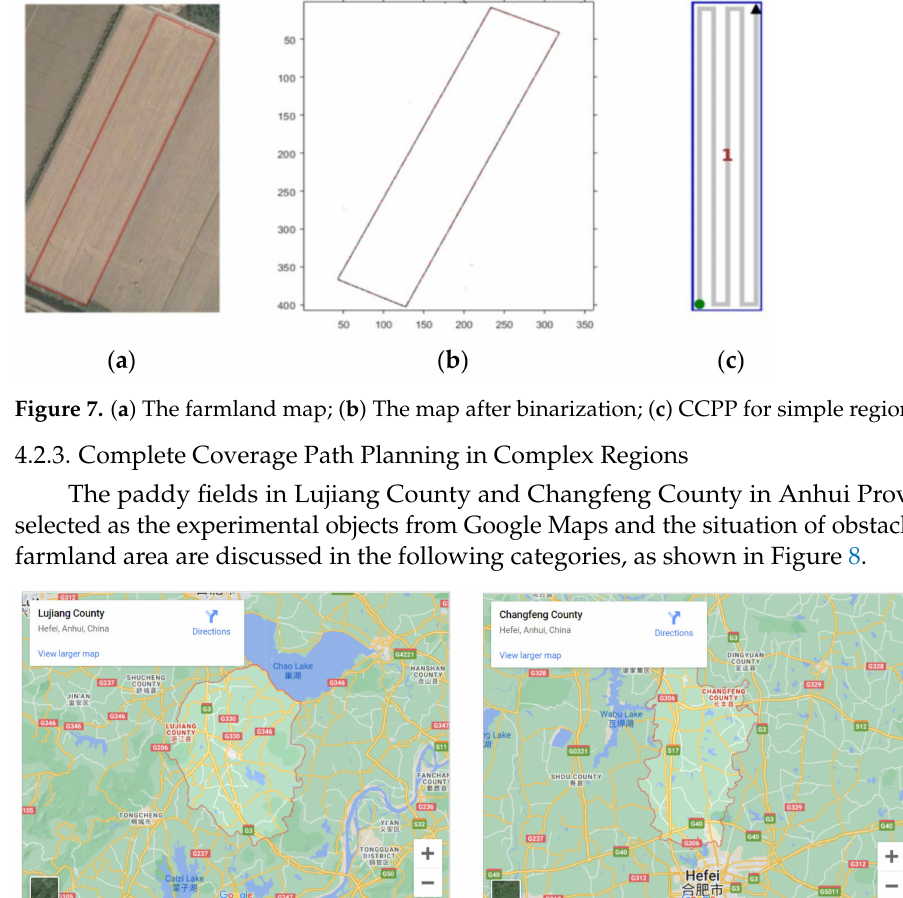
Figure 8. The location of Lujiang County and Changfeng County on the map.